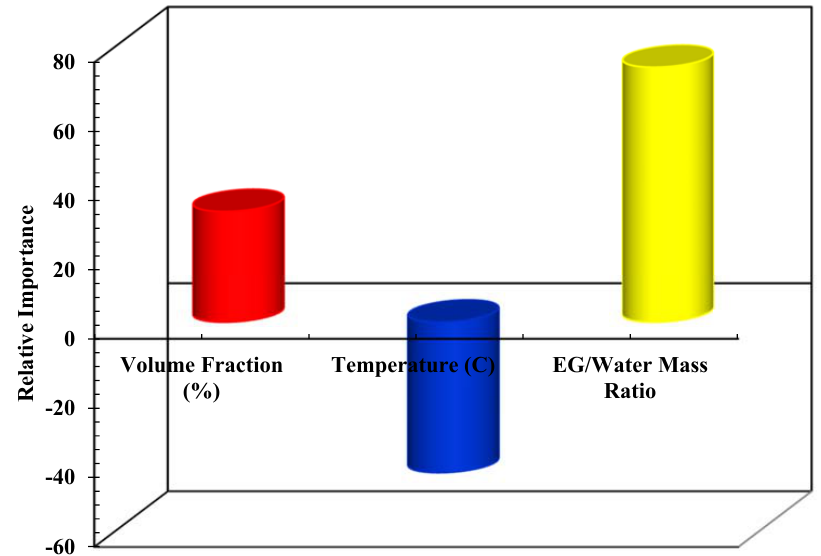
Figure 10. Relative importance of each input variables on the viscosity of Fe 2 O 3 /ethylene glycol-water nanofluid.